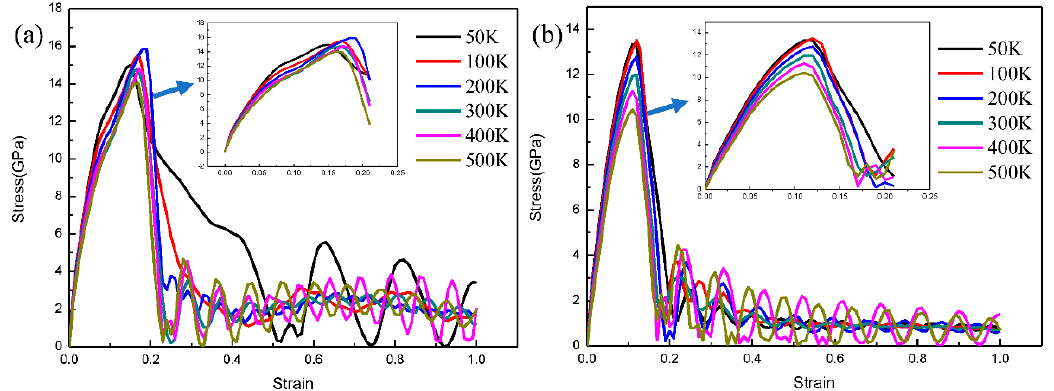
Figure 12. Strain–stress curves of z-axis tensile of Fe (111)/Cu (111) interface before and after diffusion under different temperature. ( a ) z-axis tensile stress–strain curve before diffusion; ( b ) z-axis tensile stress–strain curve after diffusion.